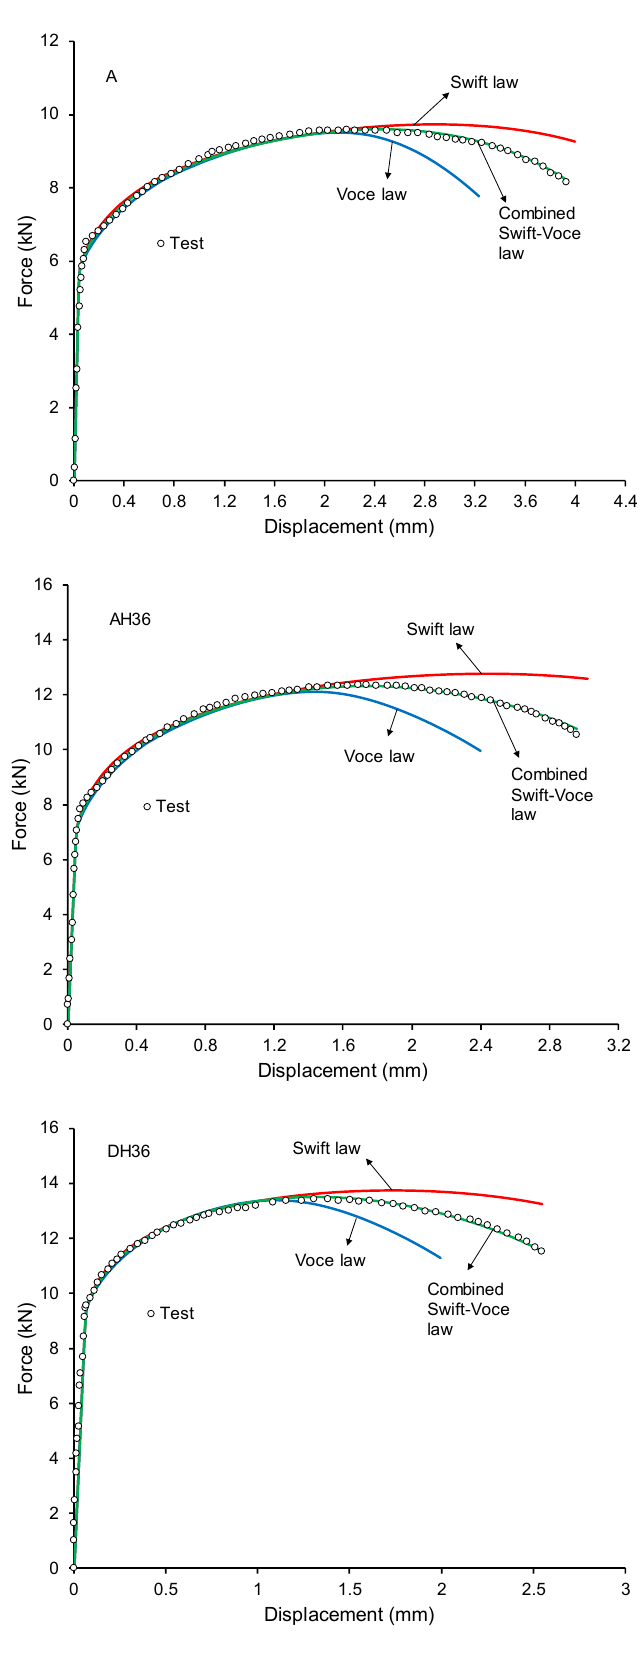
Figure 11. Comparison of the measured and simulated force-displacement curves of the NT20